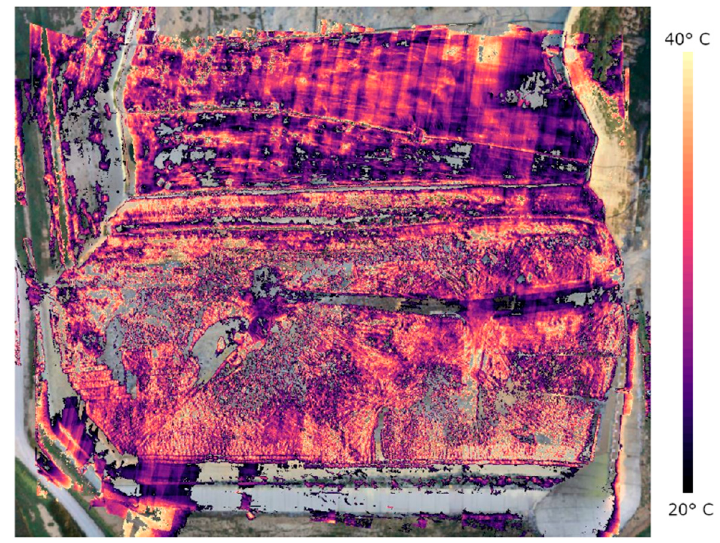
Figure 6. Mosaic thermal image of the landfill (Scala Erre) during the summer survey (July 2019).